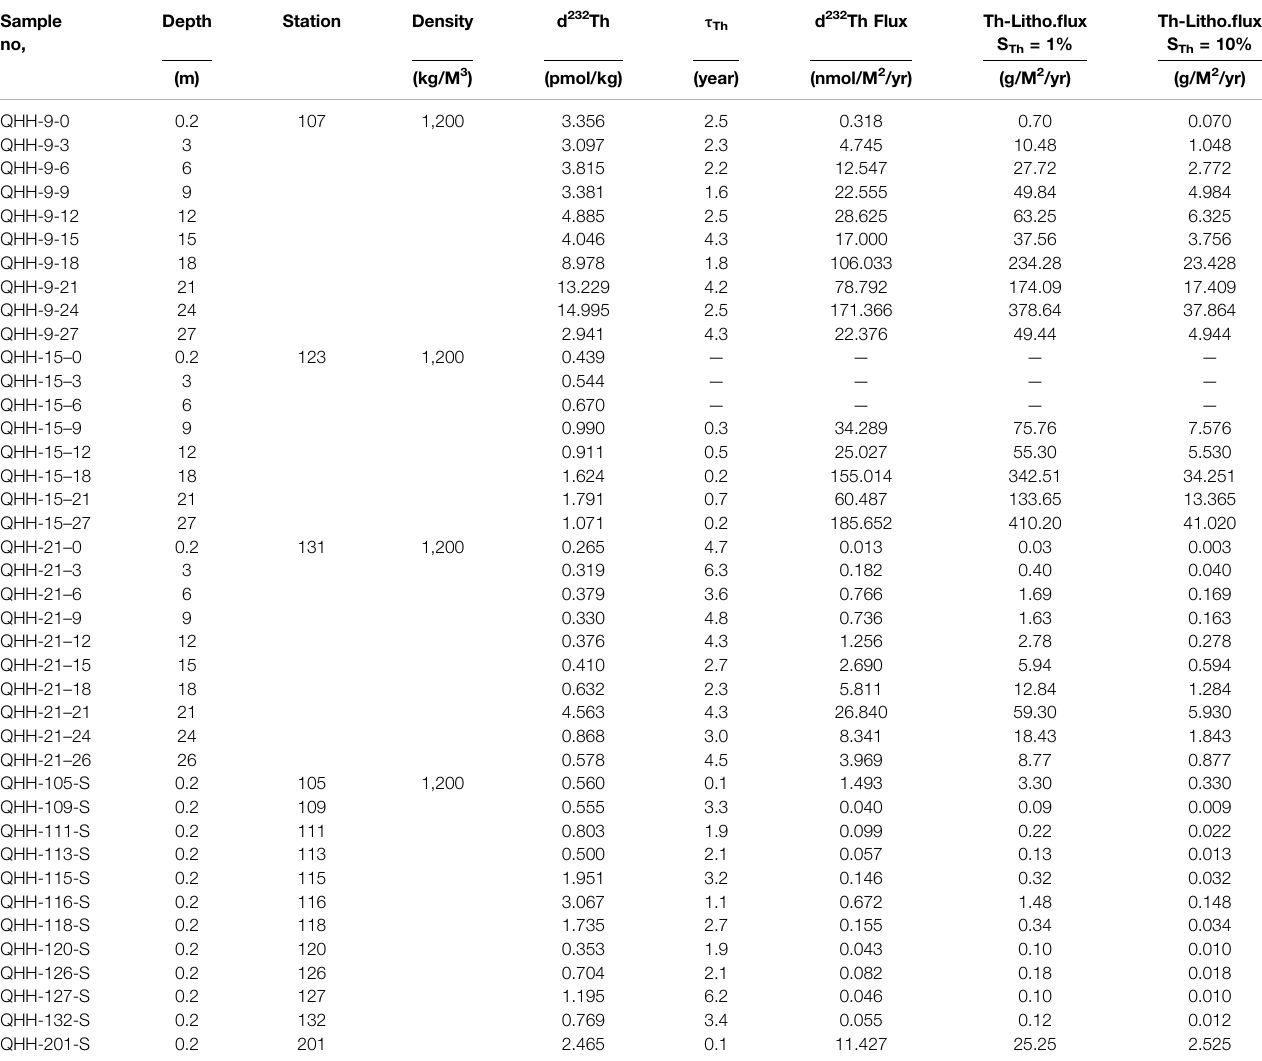
TABLE 4 | Dissolved 232 Th concentration, τ Th , dissolved 232 Th fl ux and lithogenic fl ux of Qinghai Lake. Sample no,